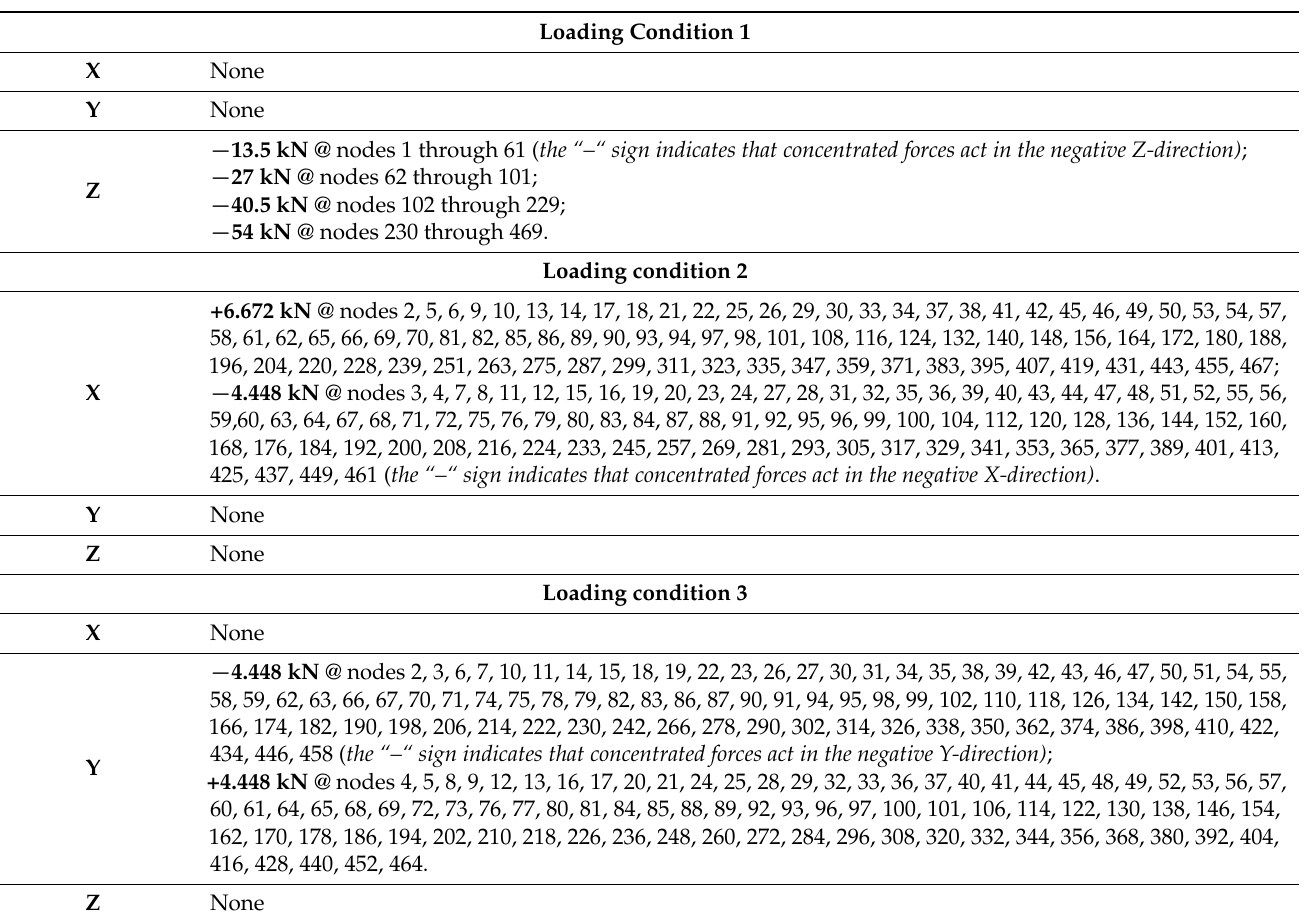
Table 3. Loading conditions acting on the 1938-bar